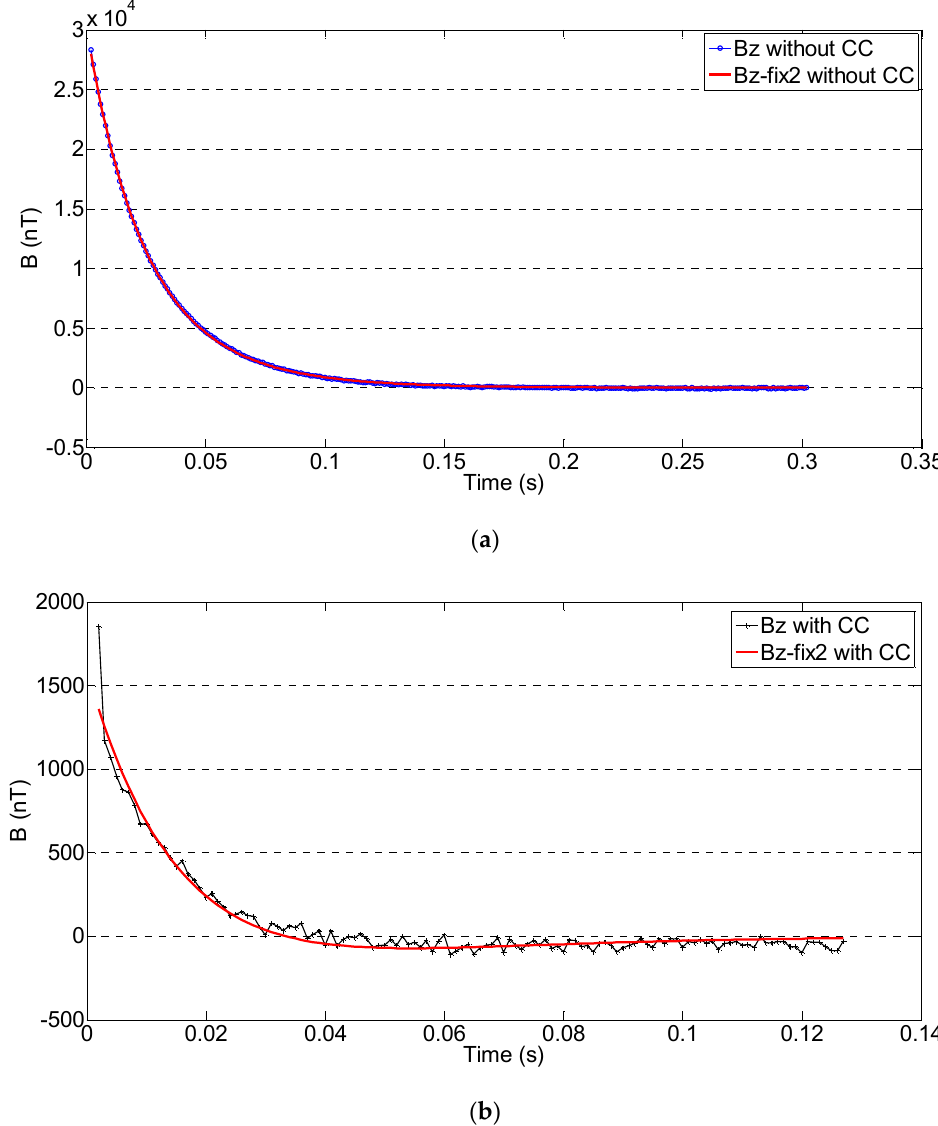
Figure 10. ( a ) Curve fittings of the residual magnetic in z direction field without CC. Circled blue curve is experimental data after t s = 2 ms; red curve B z-fix 1 is the fitting curve; ( b ) curve fittings of the residual magnetic field in z direction with CC. ‘ + ’ type of the black curve is experimental data after t s = 2 ms; red curve B z-fix 2 is the fitting curve.